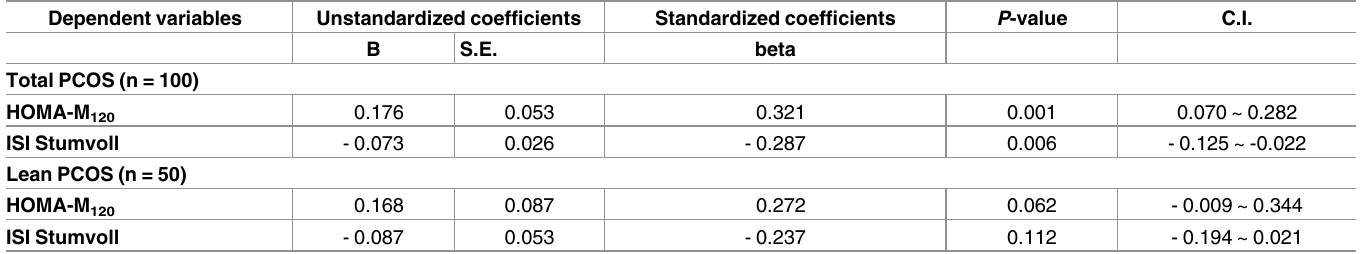
Table 3. Multiple linear regression analysesof HOMA-F for insulin resistance indices.